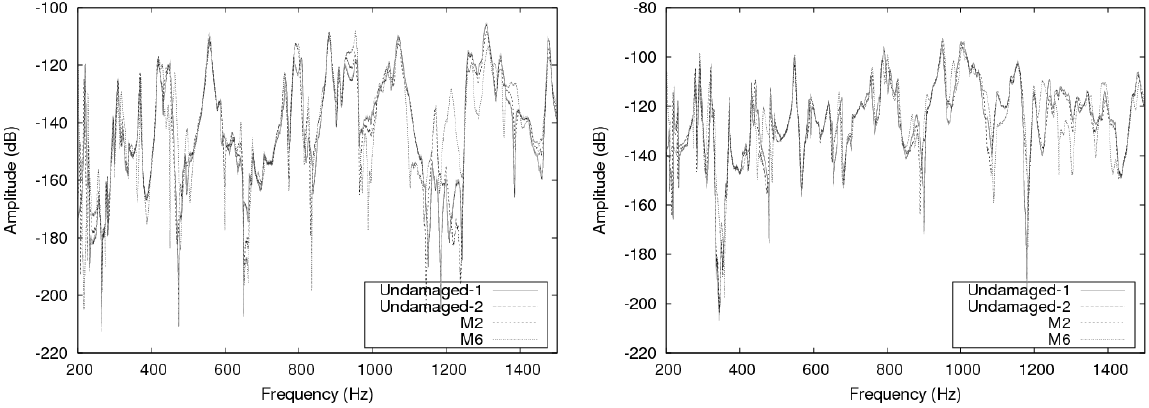
Fig. 3. FRFs for the undamaged plate and the plates with additional mass M2 and M6 at sensor S1, using the actuators A1 (left) and A2